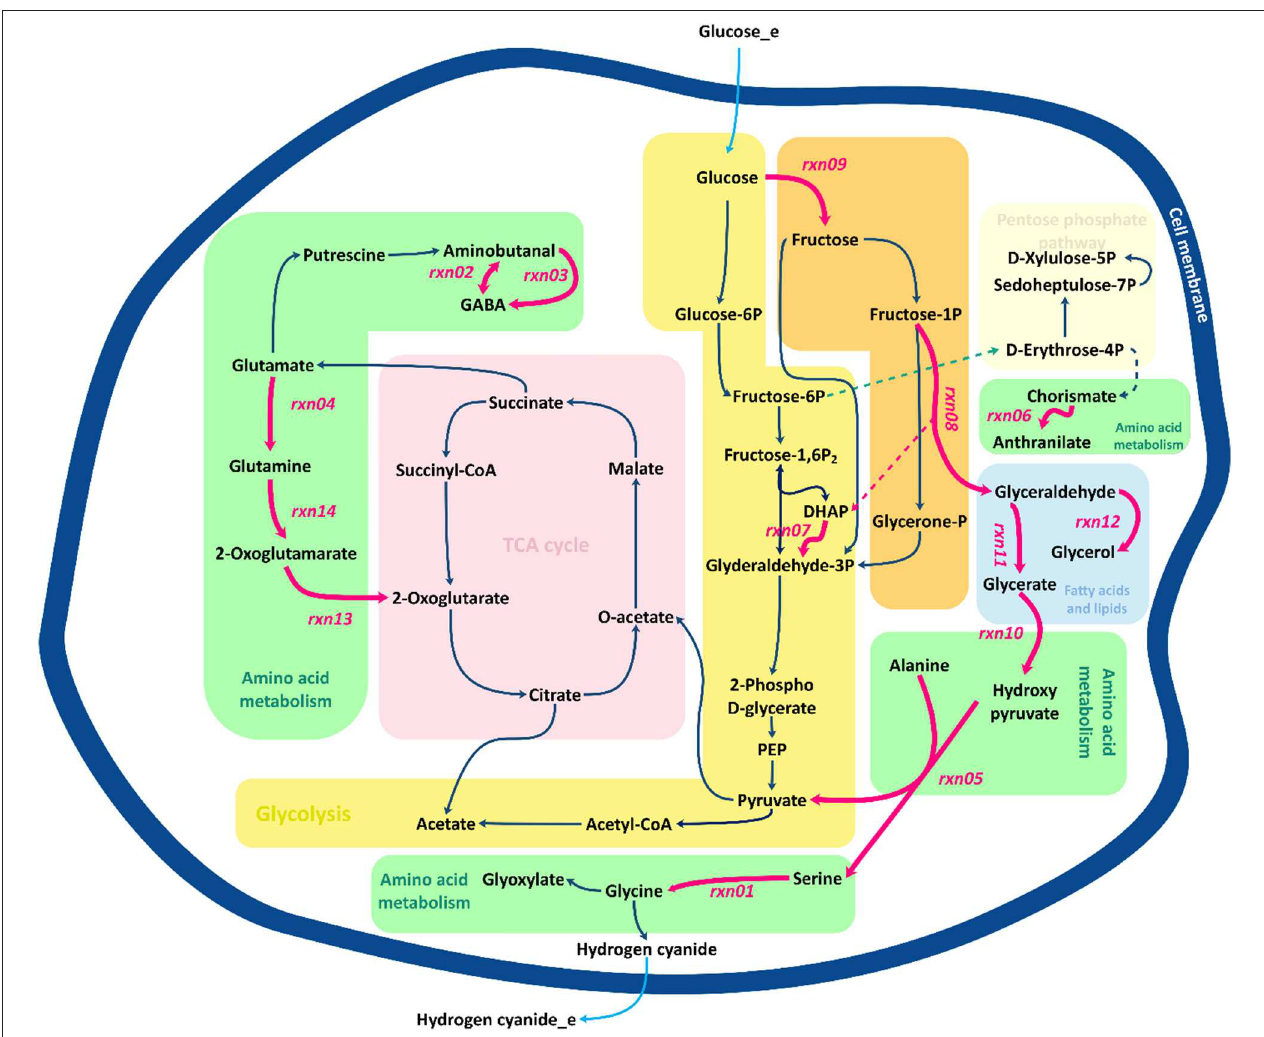
FIGURE 7 | Overview of central metabolic pathways for the amplification of target genes identified by FSEOF. Red arrows identify the reactions that are